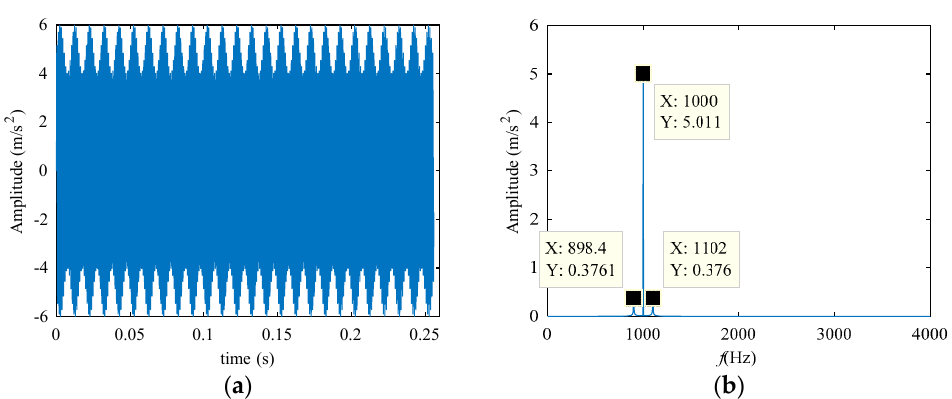
Figure 5. The Amplitude-Modulation signal. ( a ) Time-domain waveform. ( b ) Frequency spectrum